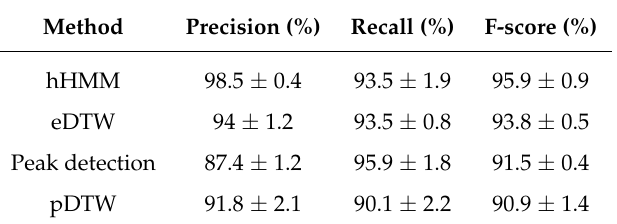
Table 4. Results of the second experiment in terms of precision, recall, and F-score.